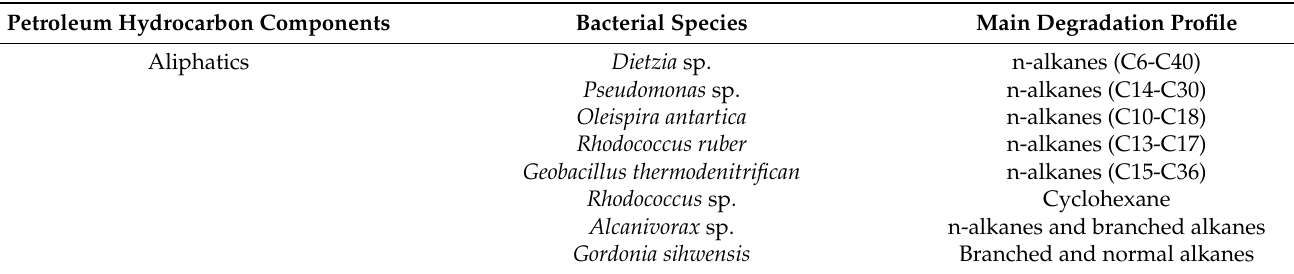
Table 1. Petroleum hydrocarbon biodegradation profile of bacteria [2]. Petroleum Hydrocarbon Components Bacterial Species Main Degradation Profile Aliphatics Dietzia sp. n-alkanes (C6-C40) Pseudomonas sp.